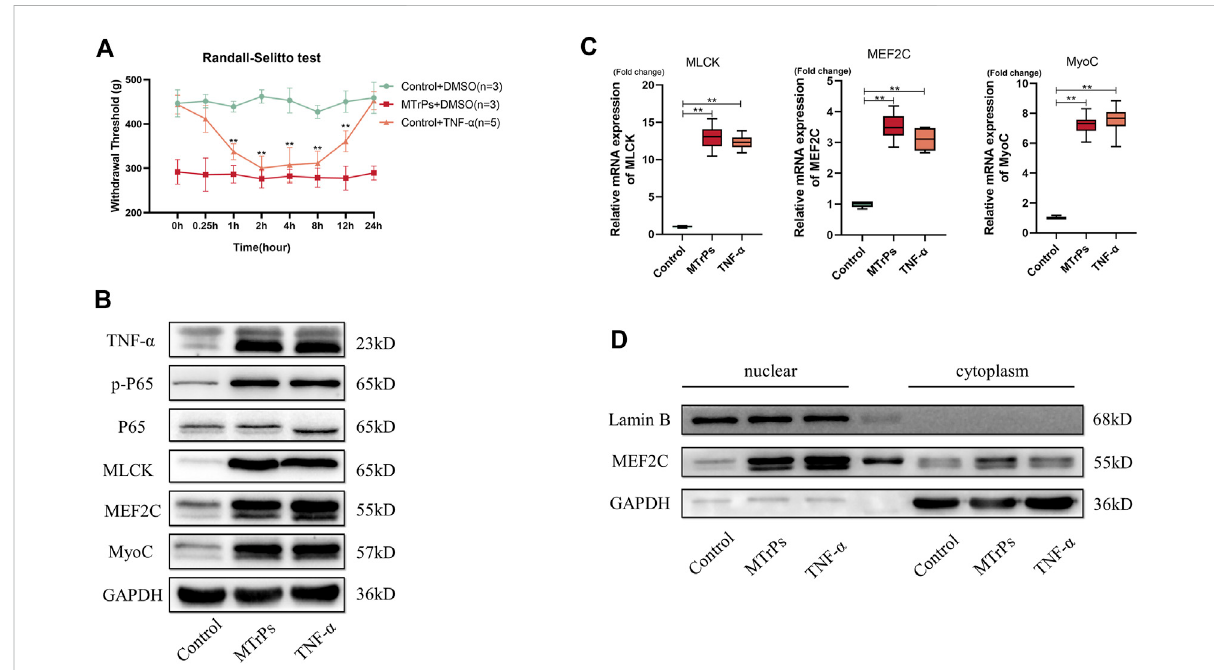
FIGURE 3 (A) Effect of TNF- α on mechanical withdrawal threshold in control group rats. Decreased mechanical withdraw threshold in control rats ( n = 5) at 1, 2, 4, 8, 12 h after intramuscular injection of TNF- α (0.1 mg/ml). (B) . TNF- α (0.1 mg/ml) could induce the high expressions of p-P65, MLCK, MEF2C, and MyoC. Expression levels were detected 2 h after injection of TNF- α or DMSO and the differences were statistically signi fi cant. (C) . The mRNAexpressionlevelsofMLCK,MEF2C,andMyoCwerehigherintheMTrPsgroupandTNF- α